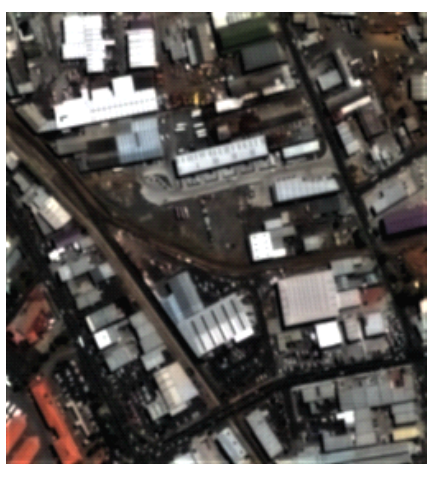
Figure 6. Fused images at full scale In summary, the improved high frequency modulating fusion method based on modulation transfer function filters can improve the spatial resolution and keep the spectral information